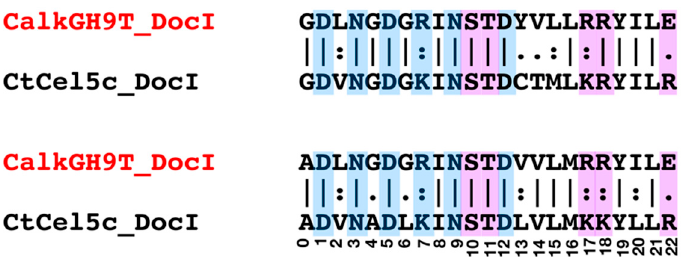
Figure 2. Pairwise alignment of Calk GH9T and Ct Cel5c dockerin modules. The sequences were aligned by use of EMBOSS Needle. The amino acid residues involved in Ca 2+ -binding loops are highlighted in cyan, and those involved in binding recognition with cohesin are highlighted in magenta.